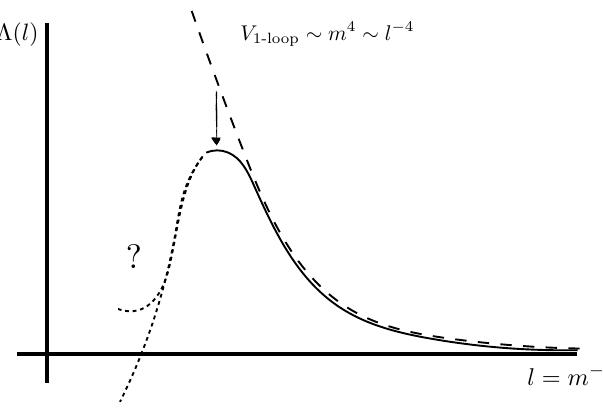
Figure 1 . Schematic representation of the vacuum energy of the Dark Dimension as a function of its size. We expect that for large values of the radii, the one-loop effect which goes like m 4 dominates the potential leading to excess light fermions. At smaller radii, other effects may take over, resulting in either a (quasi-)dS minimum (dotted lines), or just a maximum. Barring fine-tuning, the location of the maximum is always strictly below the extrapolation of the one-loop vacuum energy curve (as indicated by the arrow), hence yielding λ 4 < 1